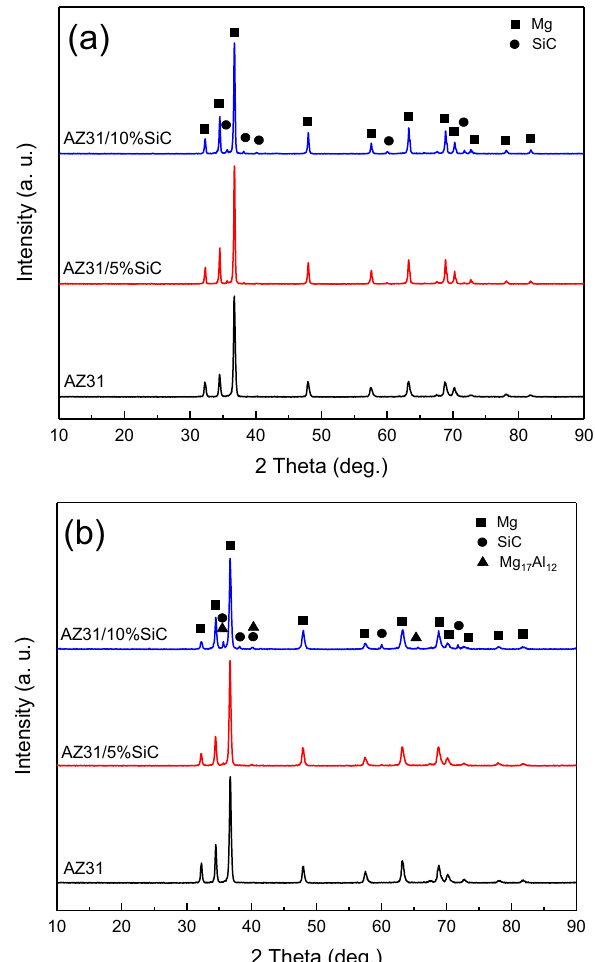
Figure 6. XRD patterns of samples: ( a ) as-cast, and ( b ) after precipitation